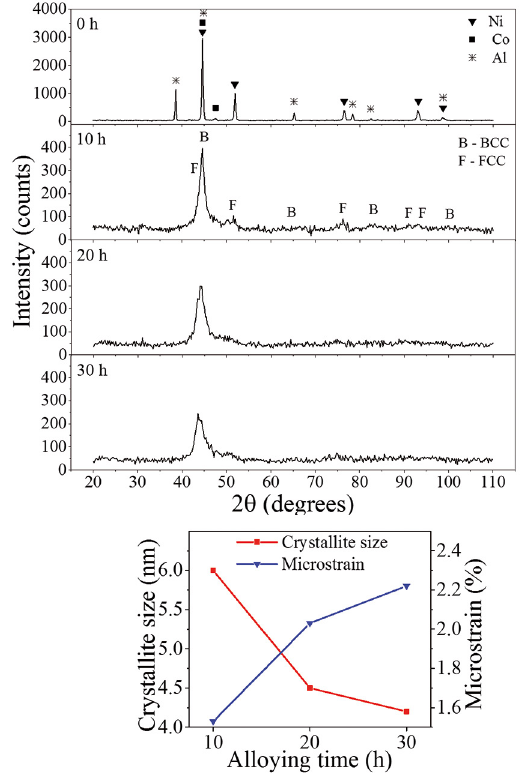
Figure 4: (a) XRD patterns of AlCoNi powder and (b) crystallite size and lattice deformation as a function of alloying time.